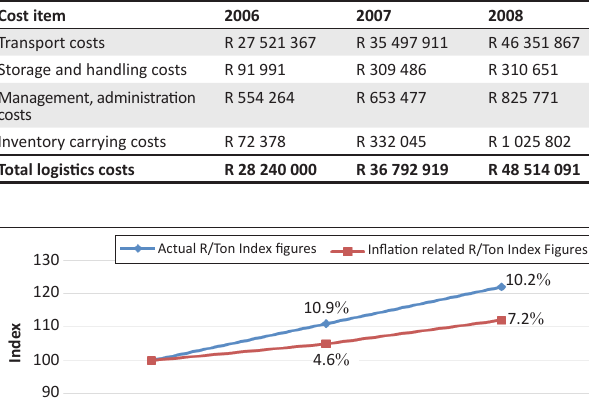
TABLE 2: Logistics costs of Firm A